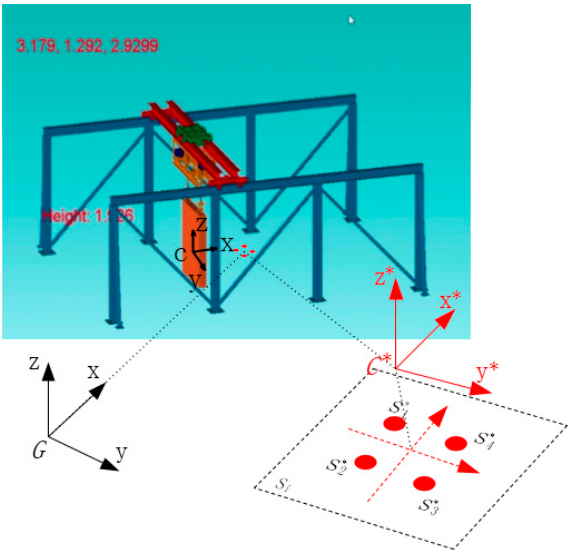
Figure 4. Simulation platform and coordinate system.